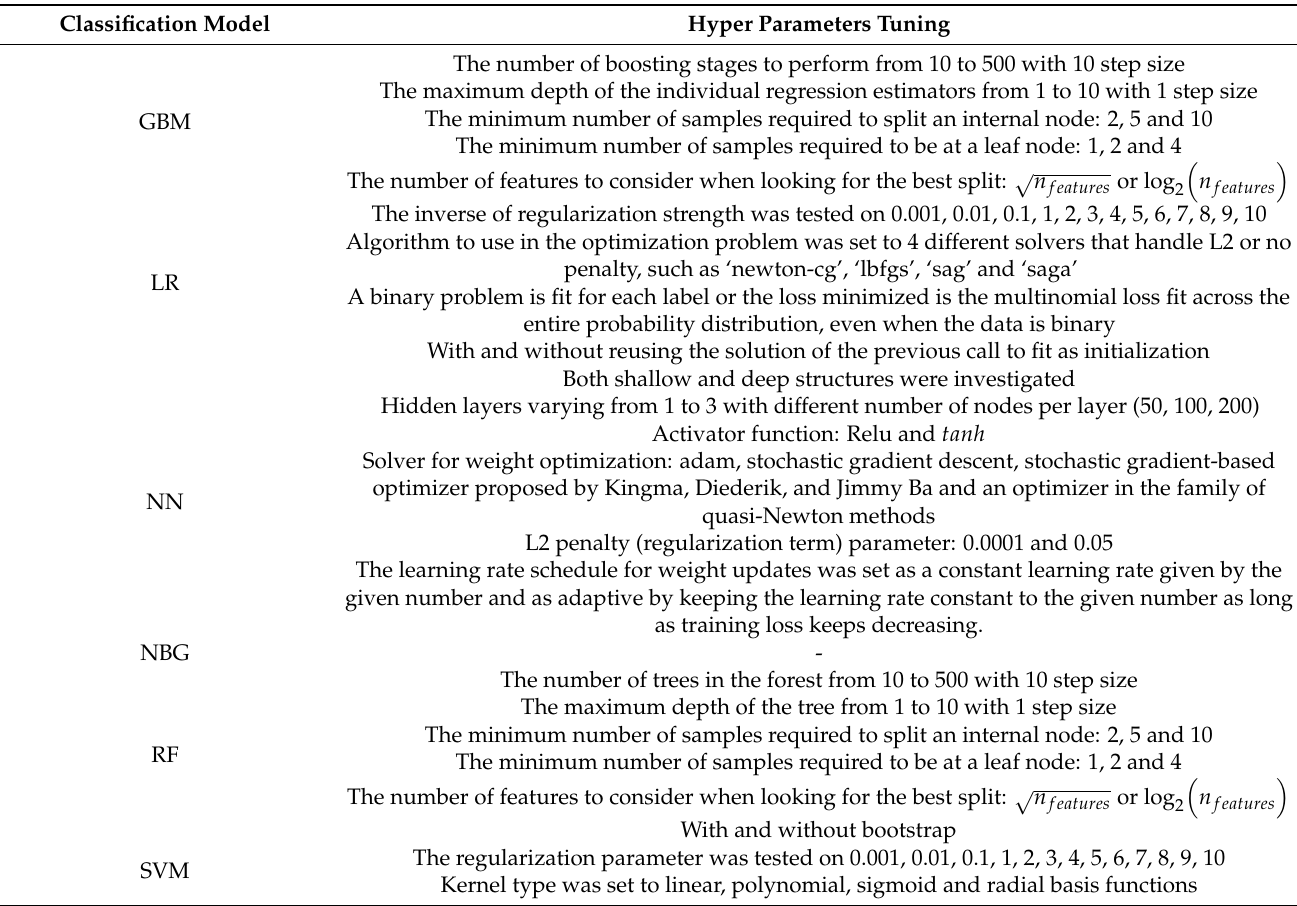
Table 3. Hyper parameter settings for tuning. GBM: Gradient Boosting Model; LR: Logistic Regression; NN: Neural Networks; NBG: Naïve Bayes Gaussian; RF: Random Forest; SVM: Support Vector Machine.